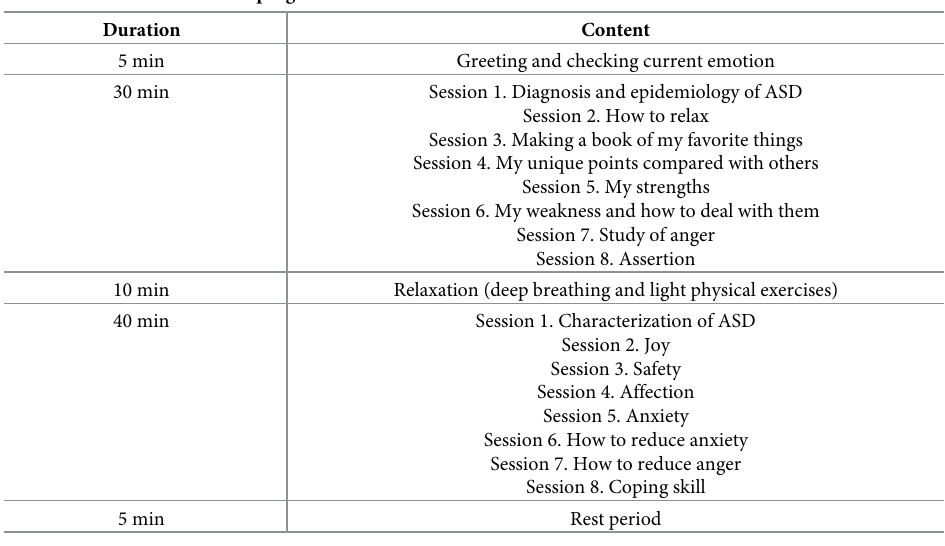
Table 1. Overview of the CBT program.